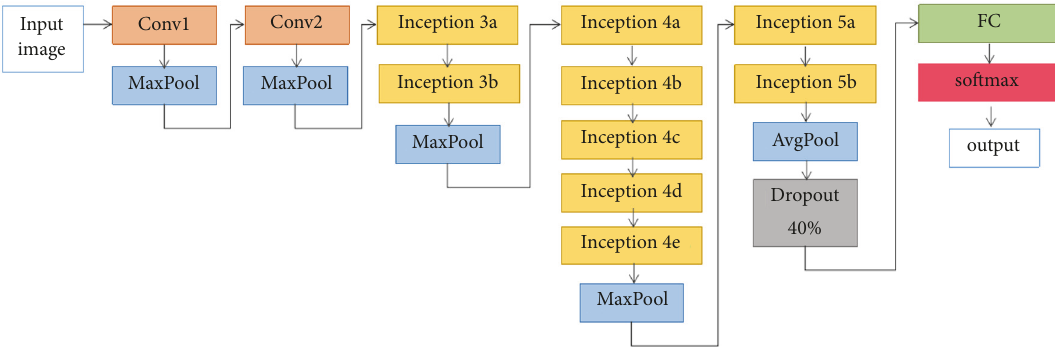
Figure 4: The architecture of GoogLeNet [22, 45].